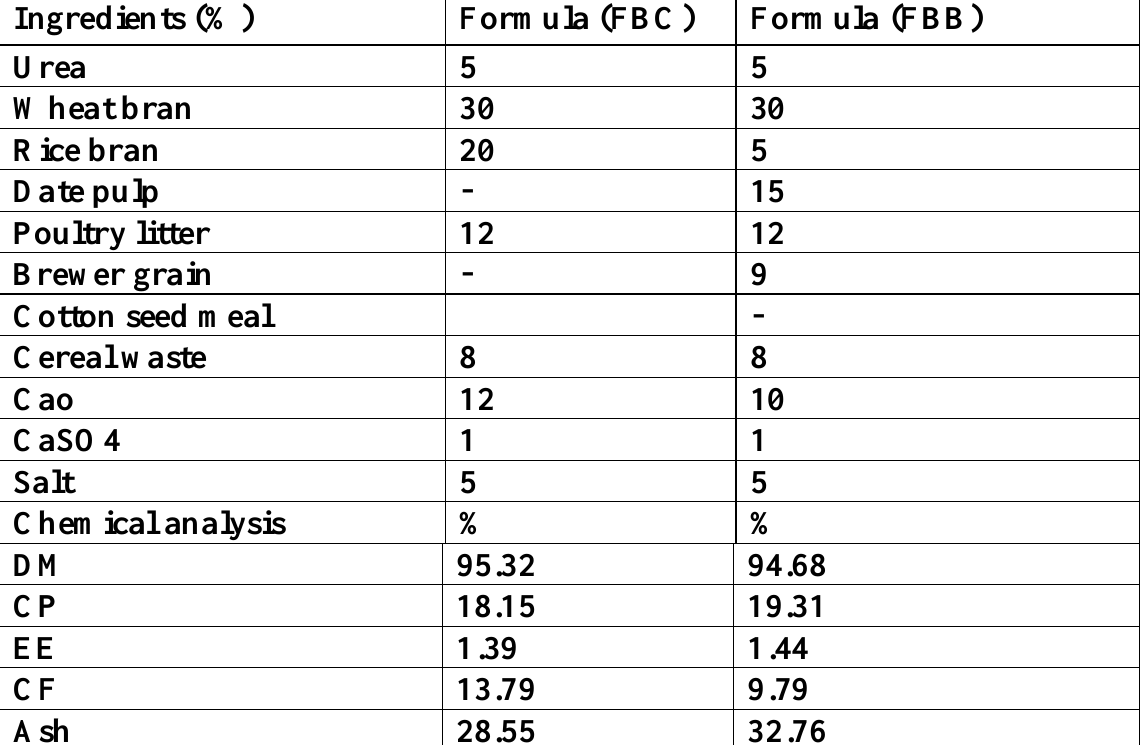
Table 1: The formulae of feed blocks and their chemical